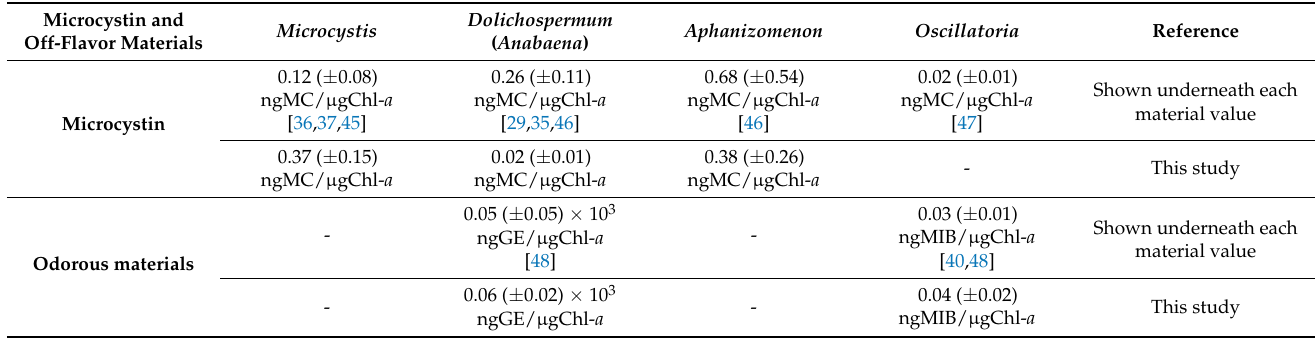
Table 3. Comparison of productivities of microcystin and off-flavor materials (geosmin and 2-MIB) produced by various cyanobacteria. Values were averaged from the same temperature range as for the reference